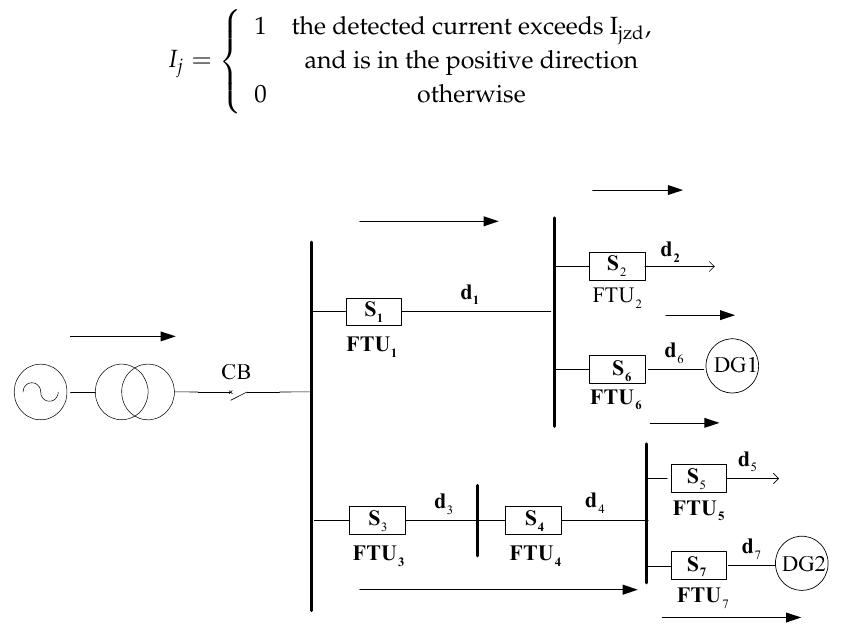
Figure 3. The structure of a DFA with two DGs using seven FTUs.